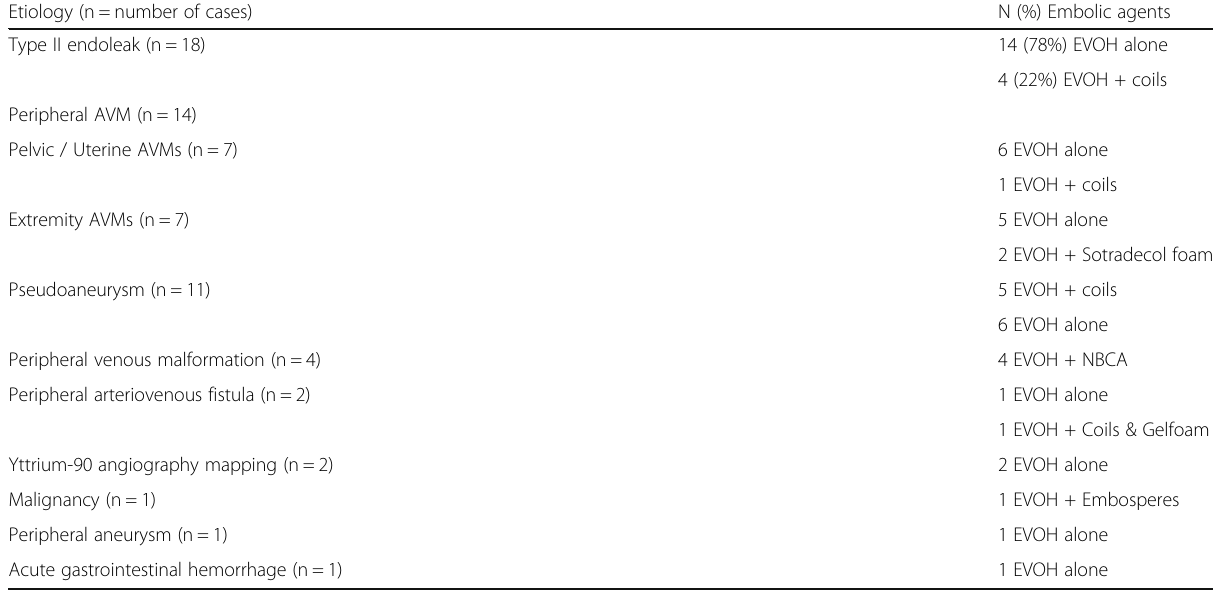
Table 4 Embolization agent based on case etiology Etiology (n = number of